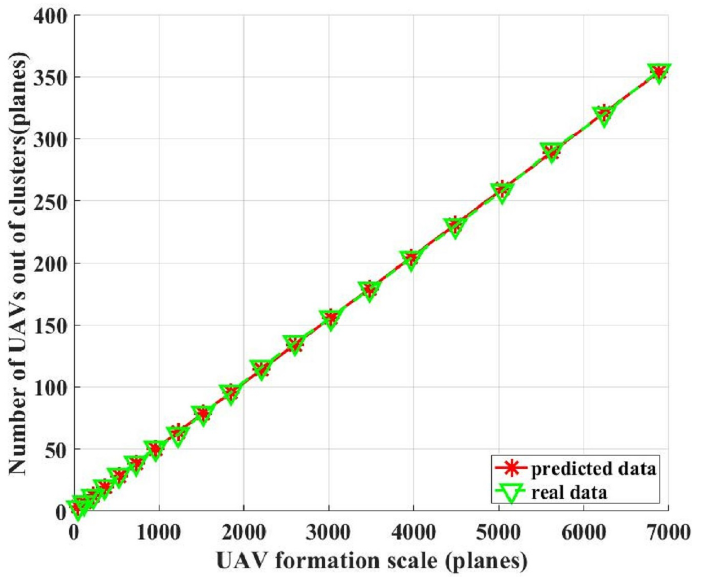
Figure 27. The regression model of the number of UAVs out of clusters under 85% fight loss in different-scale formations.